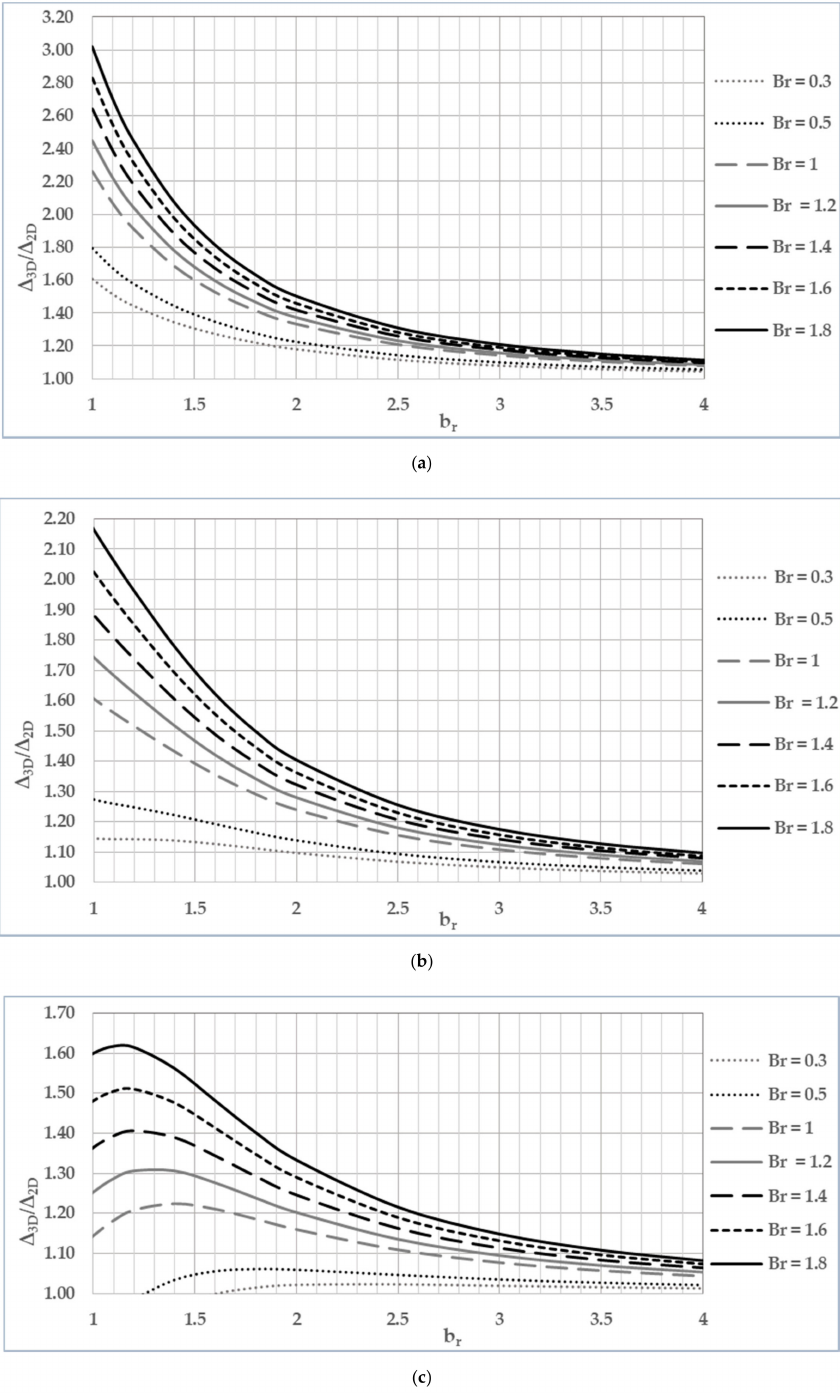
Figure 7. 3D to 2D displacement ratio: ( a ) acceleration-controlled condition ( T n 1 ≤ T 1 ); ( b ) velocity-controlled condition ( T 1 < T n 1 ≤ T 2 ); and ( c ) displacement-controlled condition ( T n 1 > T 2